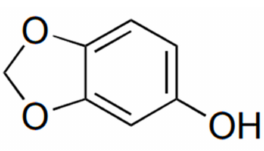
Figure 1. Chemical structure of